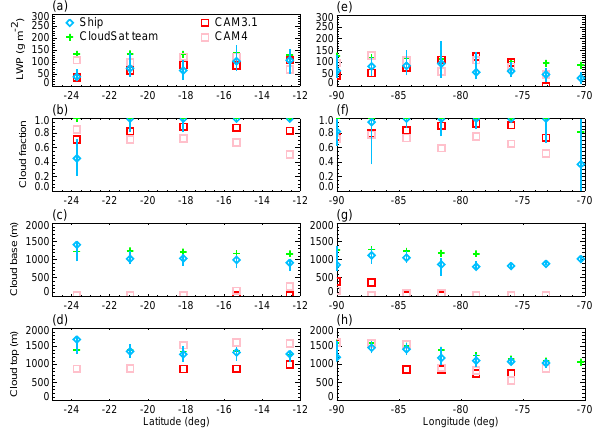
Figure 5. Same as Figure 3 showing data only from the 2001-2007 Stratus cruises (light blue diamonds, with the interquartile ranges indicated by the vertical lines) and the CloudSat team products including LWPs with suspected precipitation contamination removed and adiabatic cloud bases based on thicknesses from Eq. (1) only with simulated quantities from CAM3.1 and CAM4.